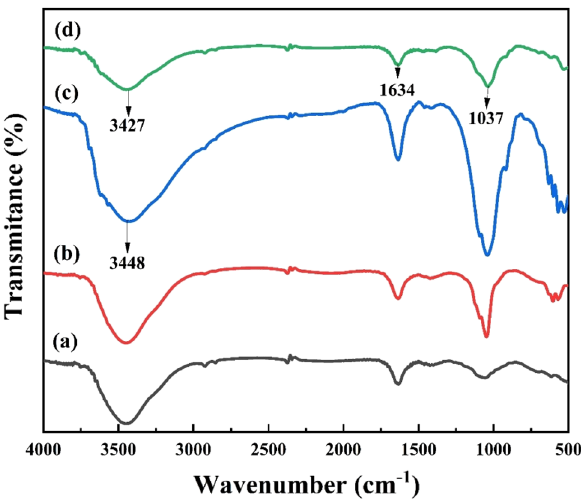
Figure 4. FTIR spectra of ( a ) bentonite, ( b ) HAp, ( c ) HAp/bentonite, and ( d ) HAp/bentonite after adsorption of Cd(II).